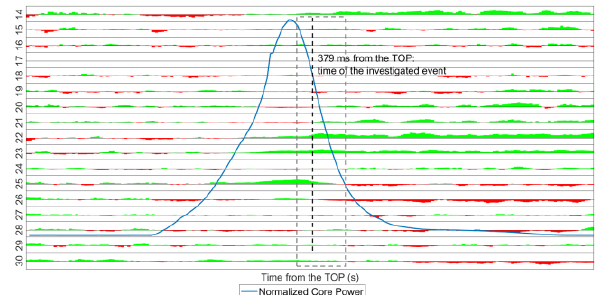
Fig. 7. Variation of the S/B before and during power excursion measured by the hodoscope’s detectors for the upper part of the fuel rod (rows 14 to 30).